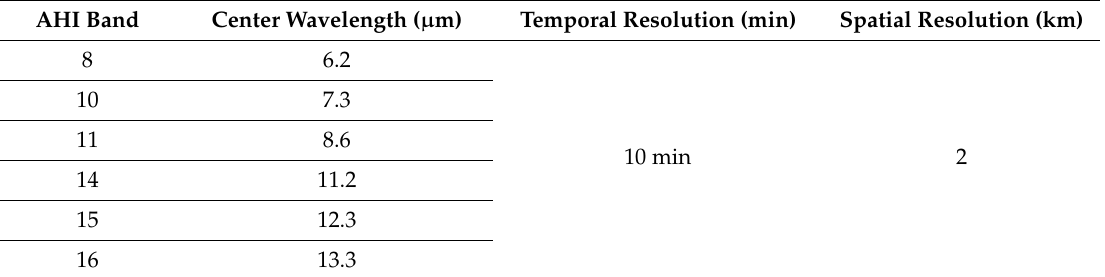
Table 1. The specification of the spectral channels of Himawari-8 Advanced Himawari Imager (AHI) that were used to develop the convective initiation (CI) detection model in this